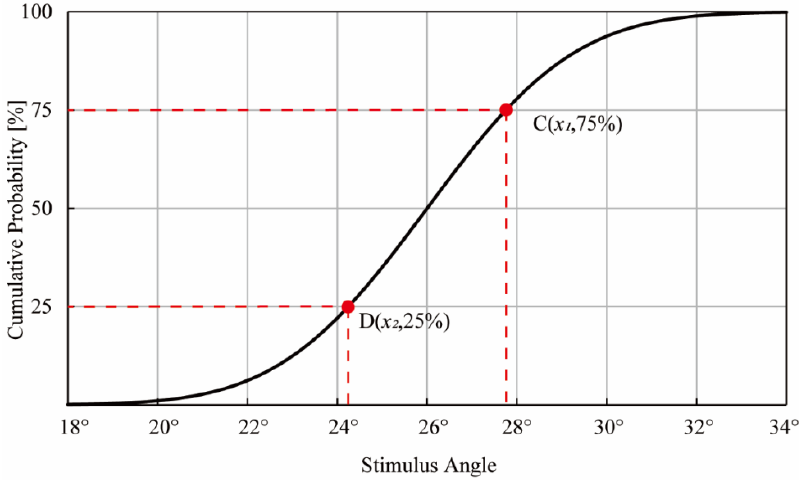
Figure 4. The relationship between the cumulative probability and stimulus angle for the condition of the reference stimulus angle 26 ◦ and σ = 2.6. The horizontal axis indicates the stimulus angle, of the reference stimulus angle 26° and 𝜎 = 2.6 . The horizontal axis indicates the stimulus angle, and the vertical axis indicates the cumulative probability. C ( x 1 , 75%) and D ( x 2 , 25%) denote the and the vertical axis indicates the cumulative probability. C ( 𝑥 1 , 75%) and D ( 𝑥 2 , 25%) denote the threshold coordinates. 𝑥 1 and 𝑥 2 denote the angle discrimination thresholds from the reference threshold coordinates. x 1 and x 2 denote the angle discrimination thresholds from the reference angle.